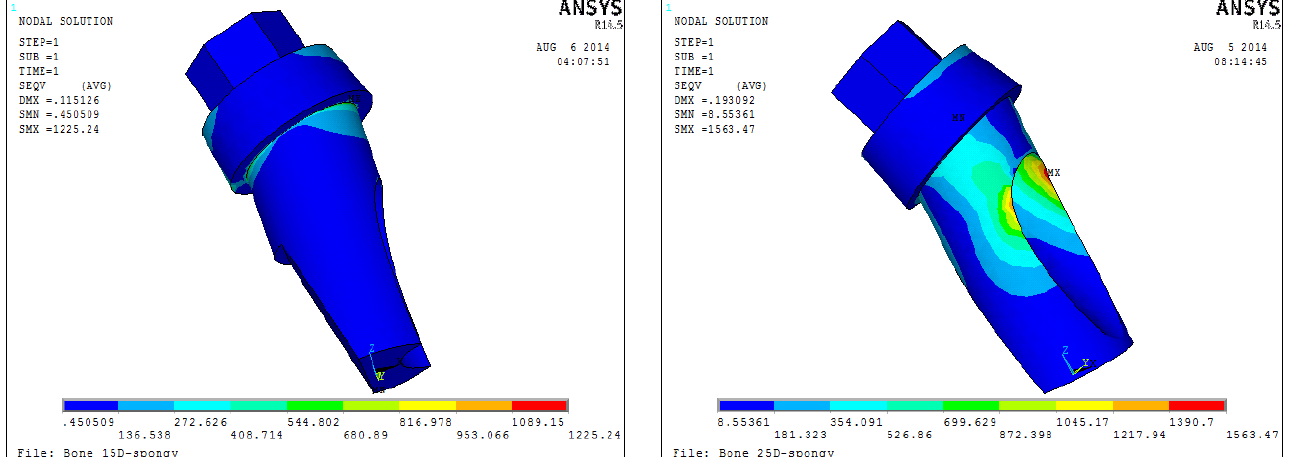
Fig. 5: Abutment Von Mises stress distribution comparison between (a) 15°, (b) 25° angulated abutment under Zirconia